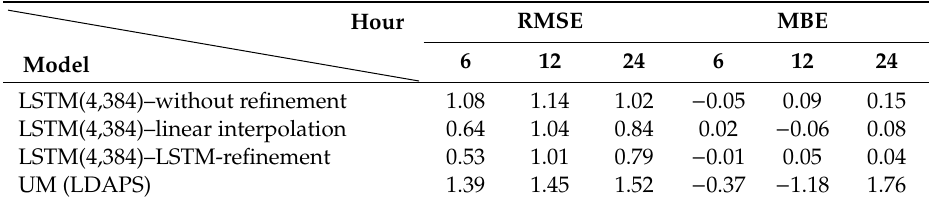
Table 6. Performance comparison of the RMSE and MBE of the LSTMs with the linear interpolation and LSTM-refinement, as well as the UM model for 6, 12, and 24 h temperature prediction.